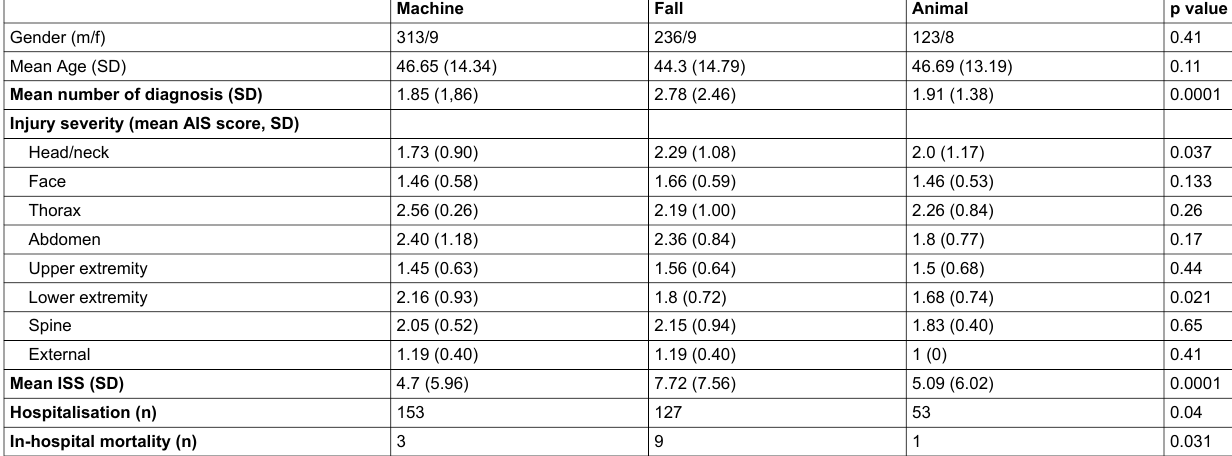
Table 3: Distribution of injury severity amongst the injury